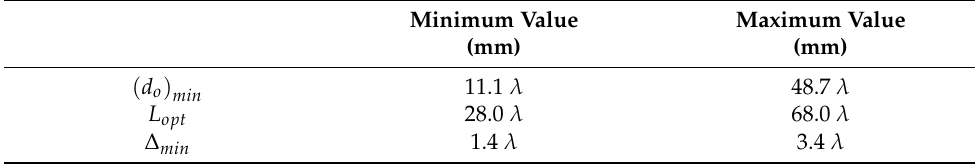
Table 4. Minimum dimensions of the RDE combustion channel using C 2 H 4 /O 2